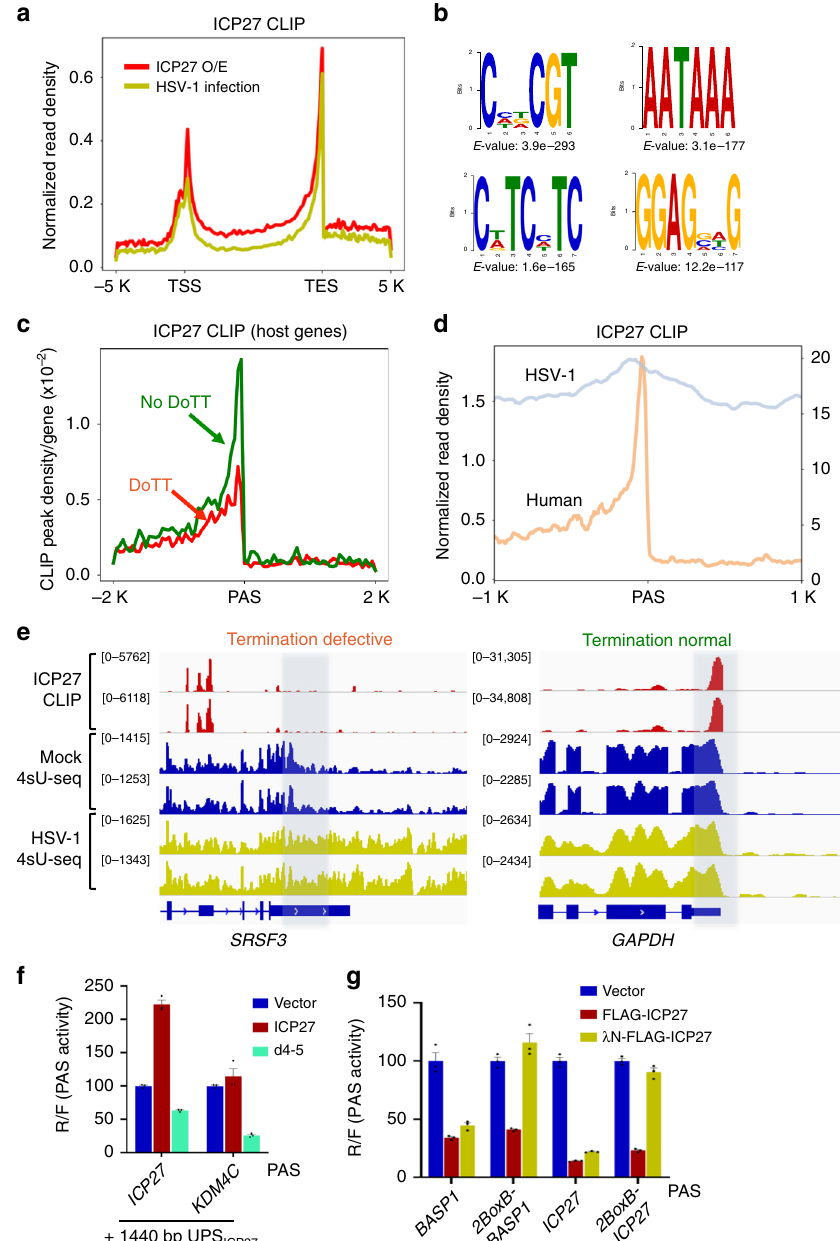
Fig. 6 The bimodal activities of ICP27 are regulated by ICP27 – RNA interactions. a Global distribution of ICP27 CLIP-seq signals along cellular genes. TSS: transcript start site. TES: transcript end site. b ICP27 CLIP-seq peak regions were analyzed by DREME and examples of the top enriched motifs are shown. c ICP27 CLIP-seq peak densities at PAS of host genes with DoTT (red) and without DoTT (green). d ICP27 CLIP-seq peak densities at the PASs of HSV-1 and host genes. e ICP27 CLIP-seq tracks at SRSF3 and GAPDH genes. For comparison, 4sU-seq tracks in mock- and HSV-1-infected cells were also shown. The region where termination normally occurs is shaded. f Wild-type or d4-5 ( Δ RGG) mutant ICP27 or control (empty vector) were co-expressed with pPASPORT constructs containing ICP27 or KDM4C PAS fused to the ICP27 UPS. PAS activities (Renilla/ fi re fl y ratio) were plotted as mean ± s.d. g Protein tethering assay. Two tandem copies of BoxB hairpin are inserted upstream of the PASs. λ N-tagged proteins will be tethered to RNAs via interactions with BoxB. pPASPORT constructs containing PASs labeled on the x axis were co-transfected with vector or Flag-ICP27 or λ N-Flag-ICP27 expressing plasmids. mRNA 3 ′ processing ef fi ciencies (Rluc/Fluc) at the PAS are plotted on the y axis as mean ±